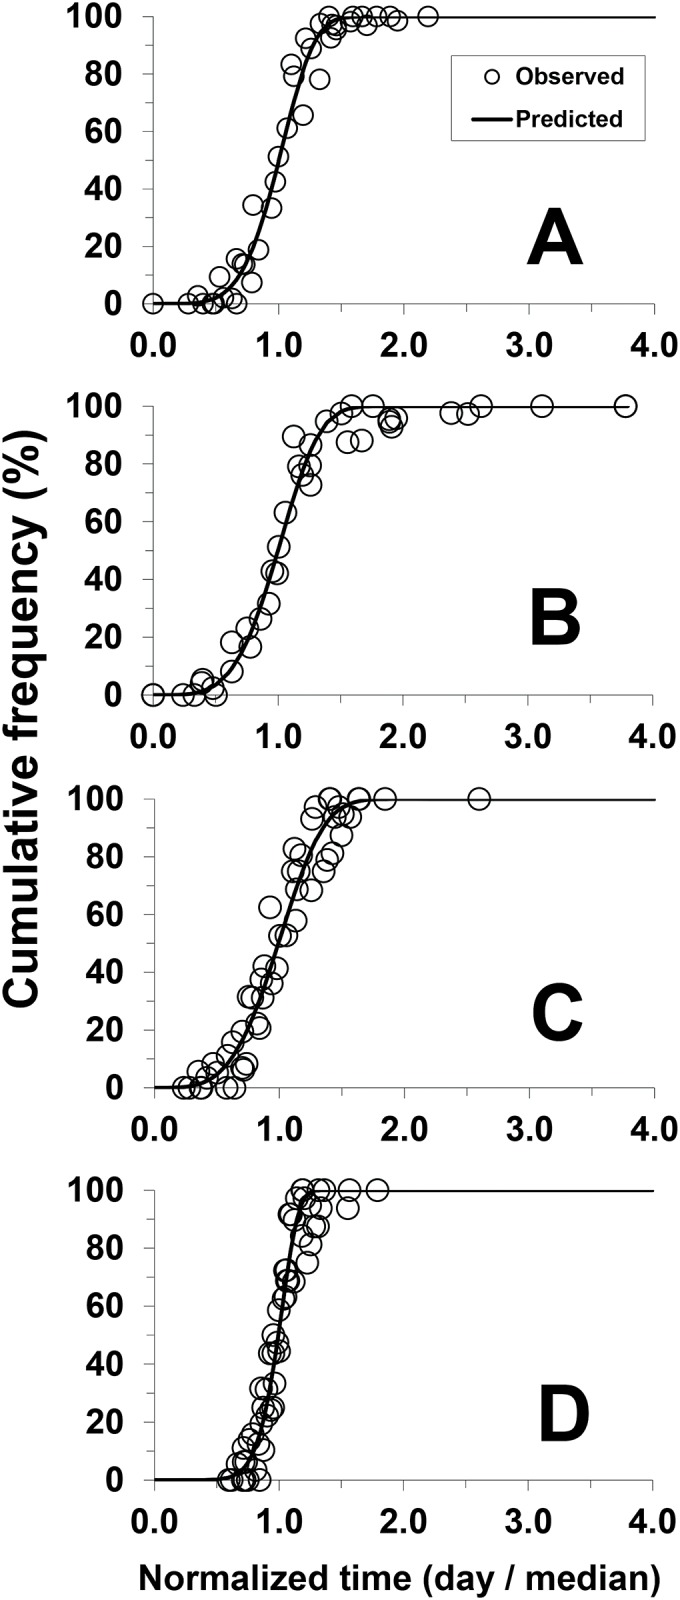
Cumulative frequency distribution (%) of C. krombeini development against the normalized time (day / median), fit to the Weibull model.A: egg, B: larva, C: nymph, and D: egg to adult.